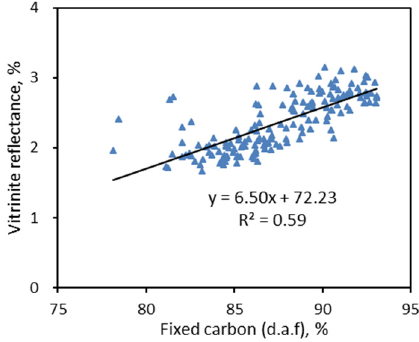
Figure 11. Dependence of vitrinite reflectance on fixed carbon of the coal samples.